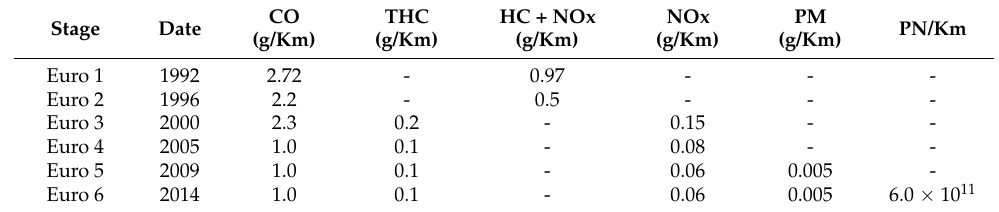
Table 1. European Union (EU) emissions standards for passenger cars (Category M1 1 ).